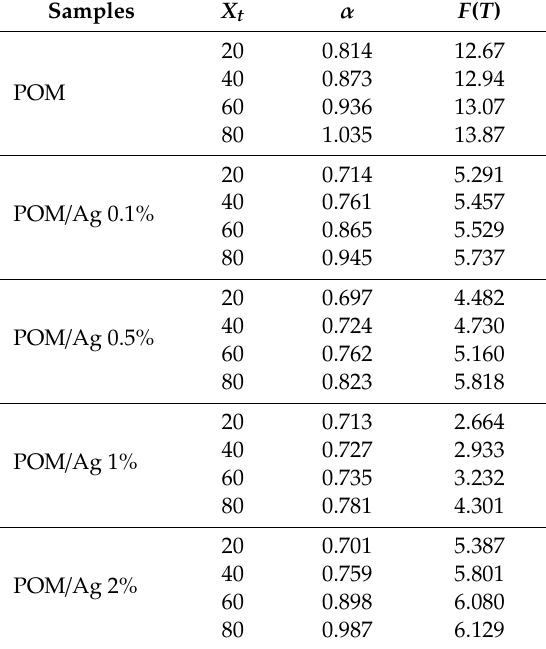
Table 4. Crystallization kinetic parameters of the POM / Ag nanocomposites at di ff erent degrees of relative crystallinity, determined from Liu and Mo’s